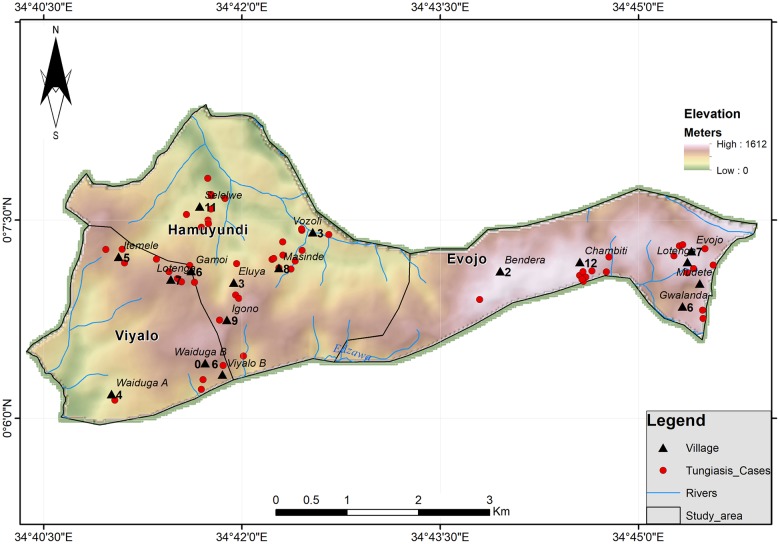
Distribution of cases in relation to elevation.